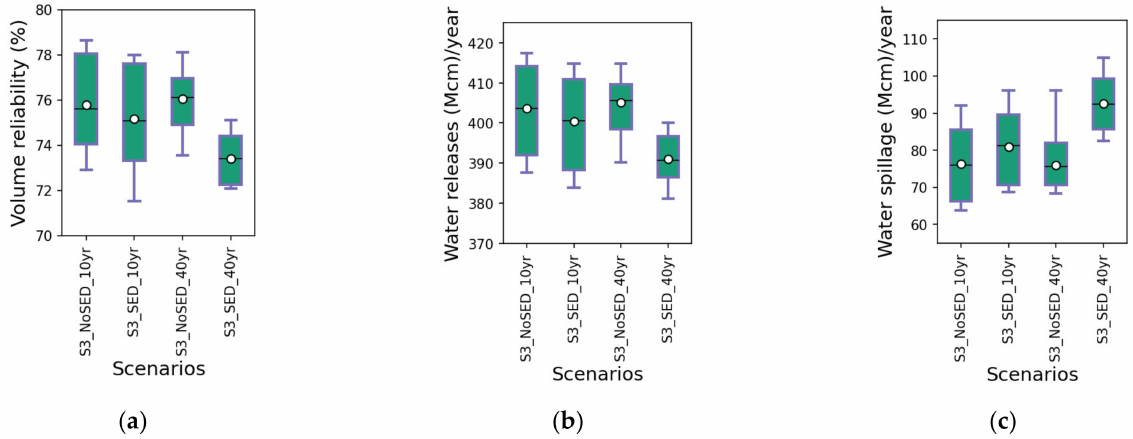
Figure 12. Water supply reliability ( a ), water release ( b ) and water spillage ( c ) under uncertainty over 10 and 40 years using the probabilistic approach with an n -value of 100 (the suffix: _NoSED: Sedimentation was not considered; _SED: Sedimentation was included; _10yr: 10-year simulation; _40yr: 40-year